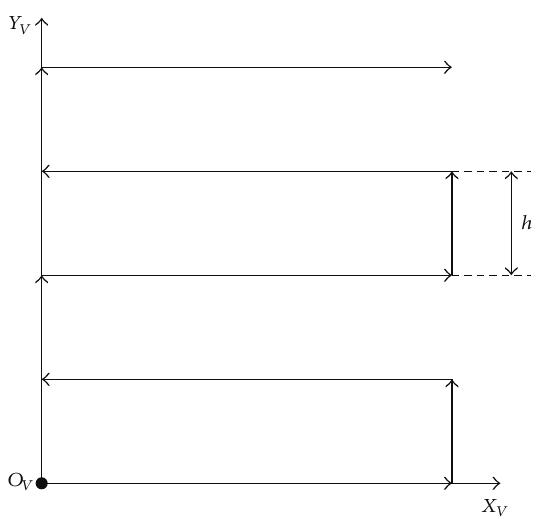
Figure 4: Sketch map of the main scanning motion.